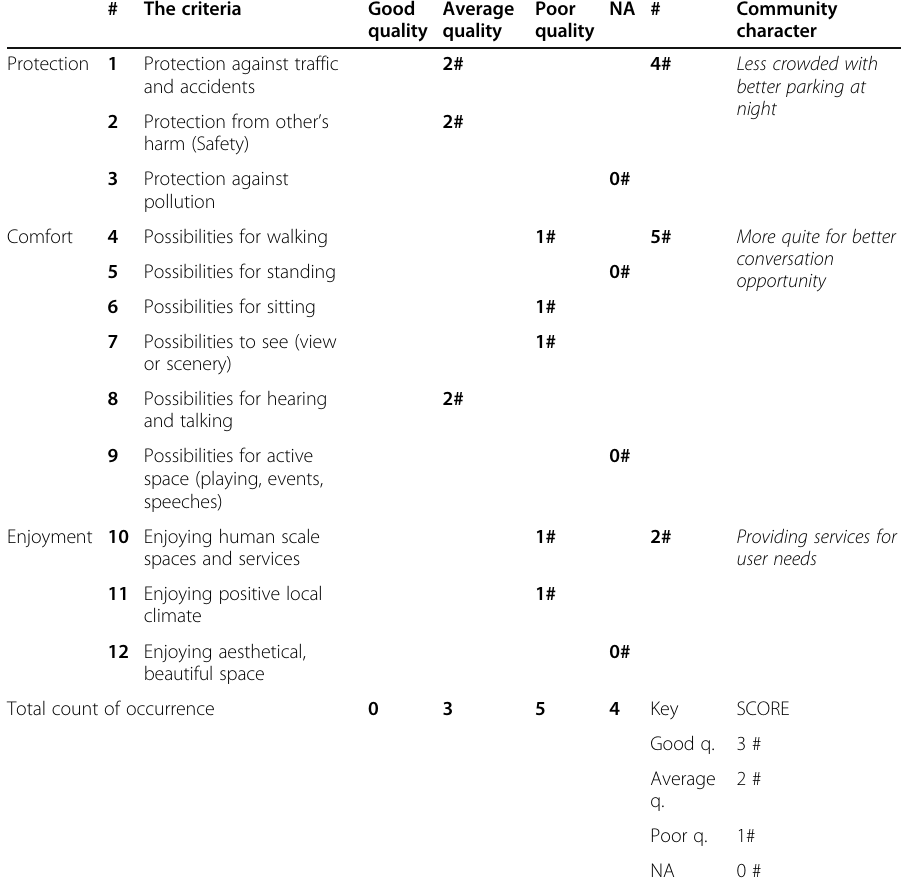
Table 2 Banks Street, New Cairo public space assessment (Author)